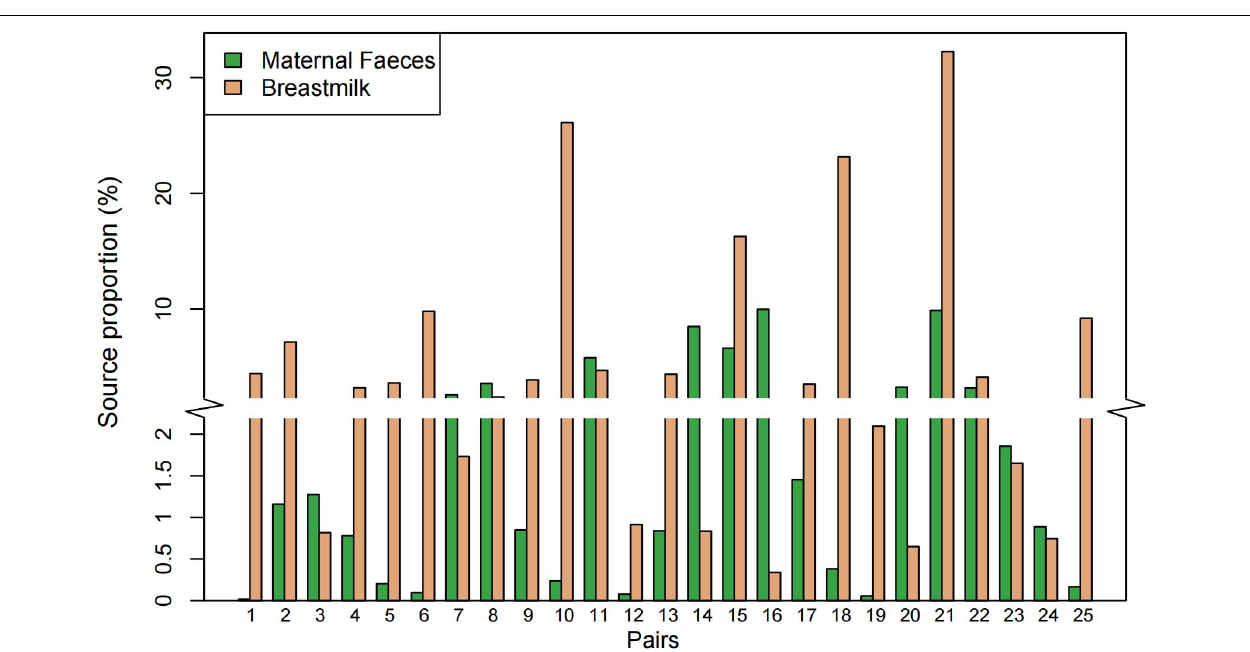
FIGURE 2 | Proportion of the microbial sources at amplicon sequencing variants (ASV) level in infant feces using the FEAST model. The y -axis truncation value is